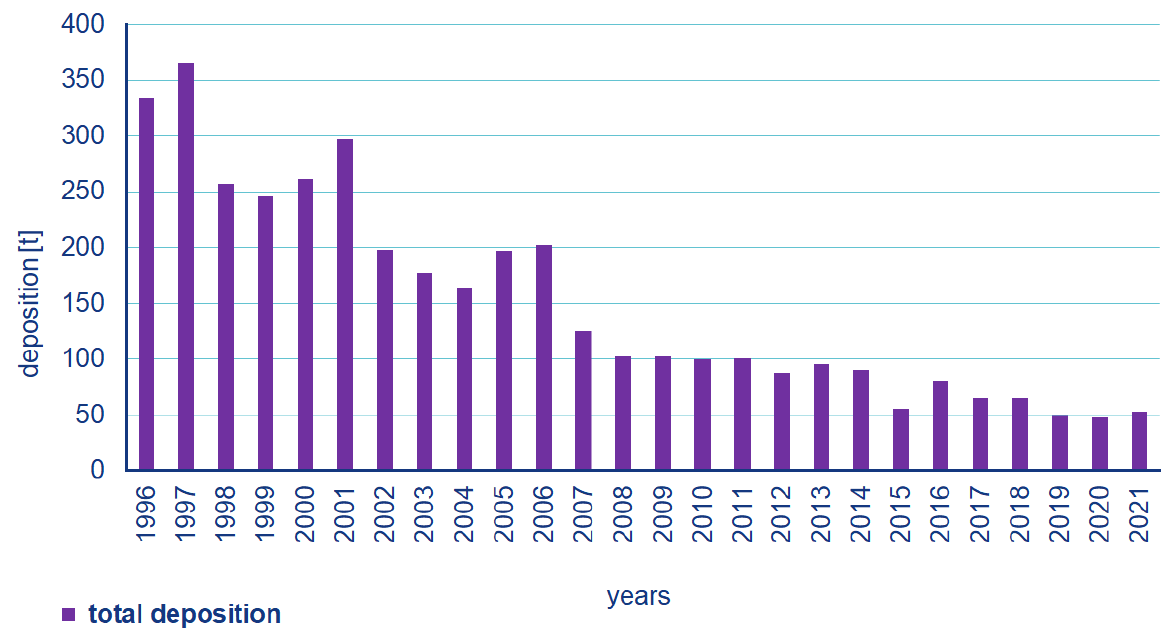
Figure 3. Estimate of annual total deposition of Pb over the entire area of the Czech Republic (78,841 km 2 ) based on data-driven geostatistic model, 1996–2021.